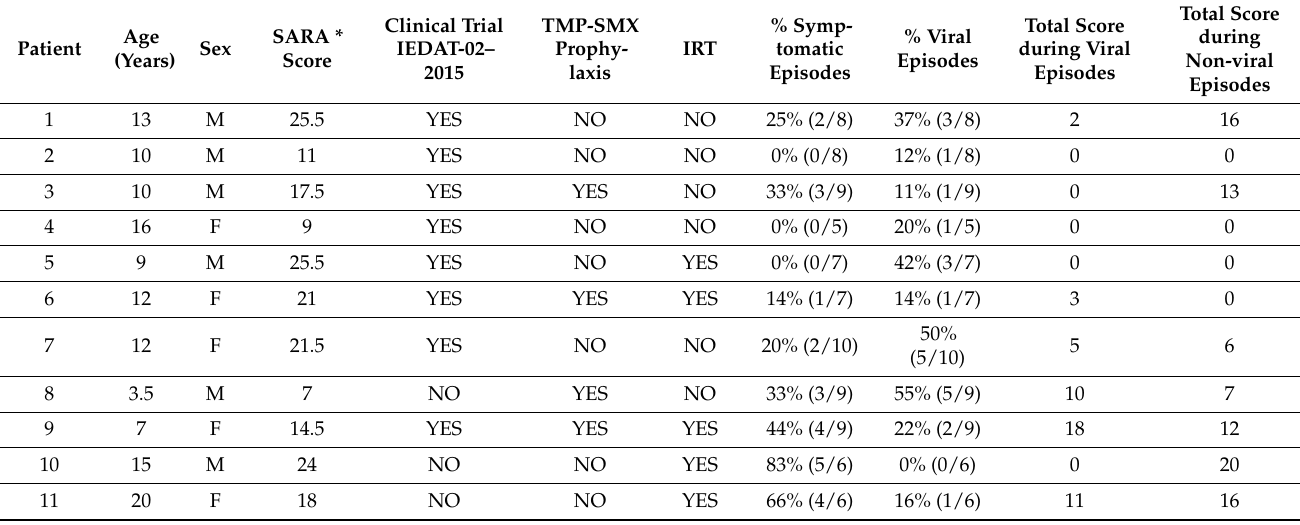
Table 2. The main clinical characteristics of included cases.